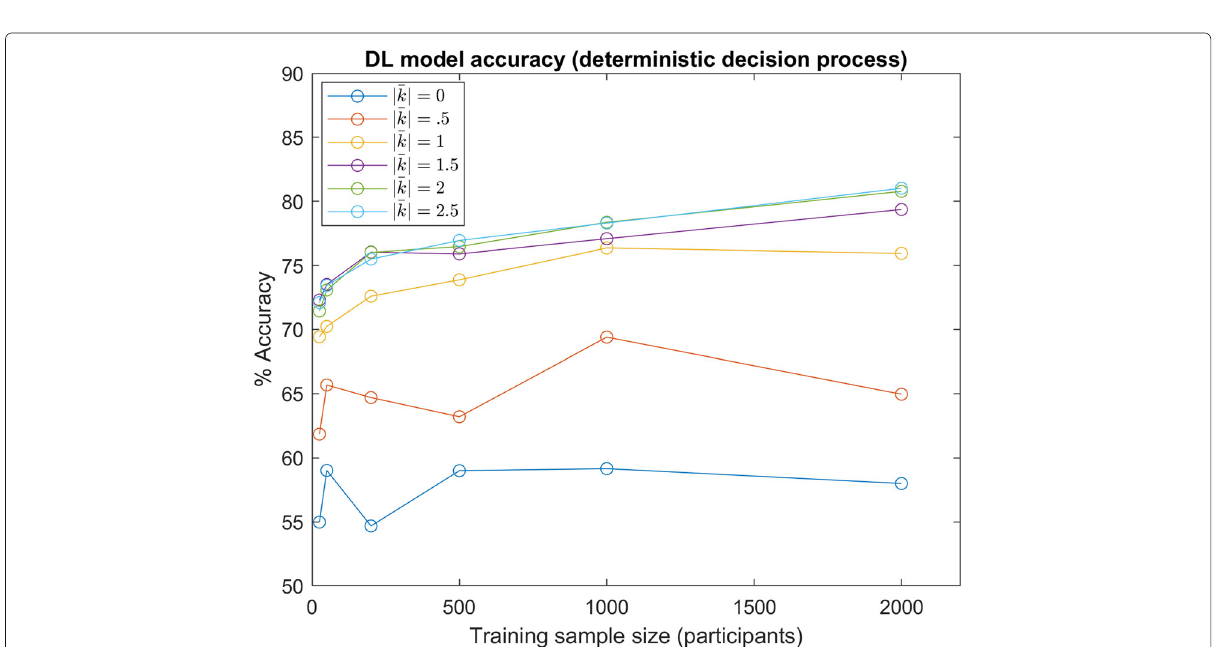
Fig. 10 DL Accuracy (Deterministic Decision Process): DL model predictive accuracy with different sample sizes and underlying distributions of w . Various distributions for w are denoted by the approximate average of absolute shape factors k ( test, decisions were simulated with the deterministic version of Eq.